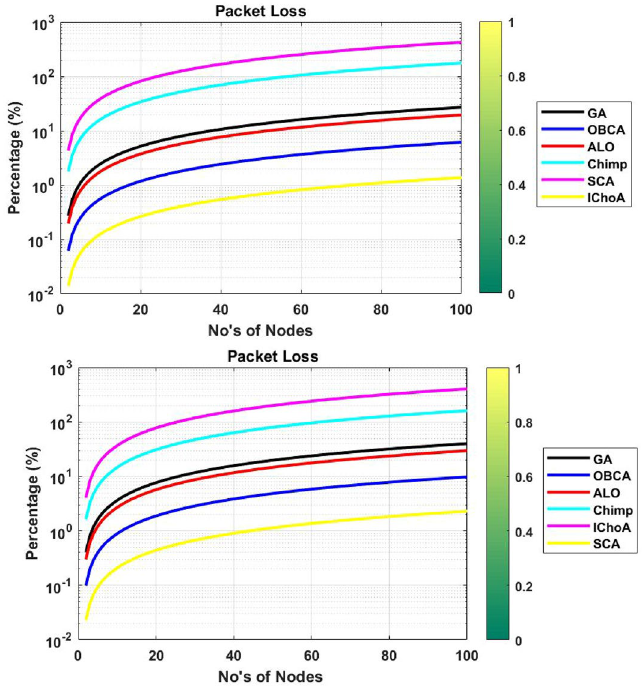
Figure 12. Packet loss graphs of metaheuristics on functions F 2 and F 6 .